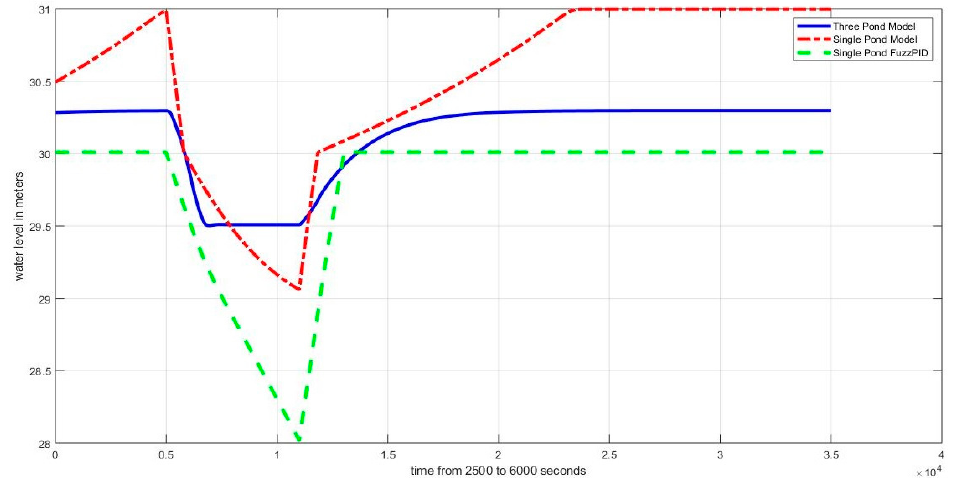
Figure 32. Traditional (Fuzzy, FuzzyPID) system vs. proposed system (negative surge, steady state).